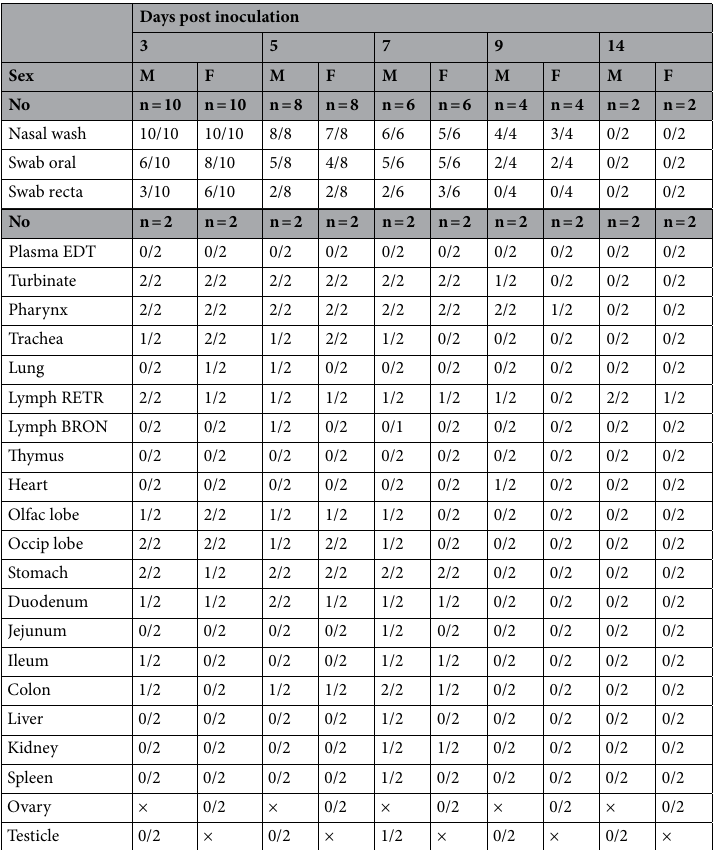
respiratory tissues, low levels of infectivity (BLOQ) were recovered from only three of 15 pharynx samples, one at days 3 (male), 5 (female), and 7 (female) respectively (Table 2). Interestingly, SARS-CoV-2 viral RNA persisted in the retropharyngeal lymph nodes up to 14 days p.i. even though all other tissues and organs were negative for viral RNA (Fig. 3). No infectious virus was recovered from the viral RNA-positive retropharyngeal lymph nodes, trachea or lung samples between days 3 and 14. When the olfactory bulb and occipital lobe of the brains were examined for SARS-CoV-2 viral RNA, both male and female ferrets showed detectable viral genomes at day 3 and 5 p.i. (Fig. 3). At day 3, three out of four ferrets (two female and one male) were positive for viral genomes in both the olfactory bulb and occipital lobe, with the remaining male ferret showing viral RNA positivity in the occipital lobe only and not the olfactory bulb. At day 5, both female ferrets had viral genomes detected in the occipital lobe, but only one with olfactory bulb positivity. On day 5 and day 7 only a single male out of each pair at sacrifice was positive by qRT-PCR, and in both cases, the olfactory bulb and occipital lobe were positive (˜ 10 6 copies/g of tissue). Viral RNA was not detected in the brain of female ferrets from day 7 to 14. Infectious virus was detected in one olfactory bulb sample collected at day 5, however no infectious virus was recovered from any of the qRT-PCR positive occipital lobe samples (Table 2). SARS-CoV-2 viral RNA was detected in the stomach and other parts of the gastrointestinal (GI) tract, such as the duodenum, jejunum, ileum, and colon. Male and female ferrets all had similar levels of recoverable viral RNA (approximately 3 × 10 6 copies/g) from stomach tissue at days 3, 5, and 7, apart from one female ferret which was undetectable on day 3 (Fig. 3A–C). Viral RNA was detected in the duodenum of ferrets at days 3, 5, and 7 in both male and female ferrets, but in most cases just one out of each pair, except for day 5 where both male ferrets were positive (Table 1). The distribution of virus to the jejunum and ileum was less consistent, with only one jejunum sample from a male ferret at day 7 being positive out of the twenty animals that were screened by qRT-PCR across the 14 days (Table 1). Three ileum samples were positive for SARS-CoV-2 RNA and two of these were in ferrets sacrificed at day 7 (one male and one female), the remaining sample from a day 3 ferret. The colon tissue collected on day 7 had slightly higher levels of viral RNA compared to those from day 3 and 5 but